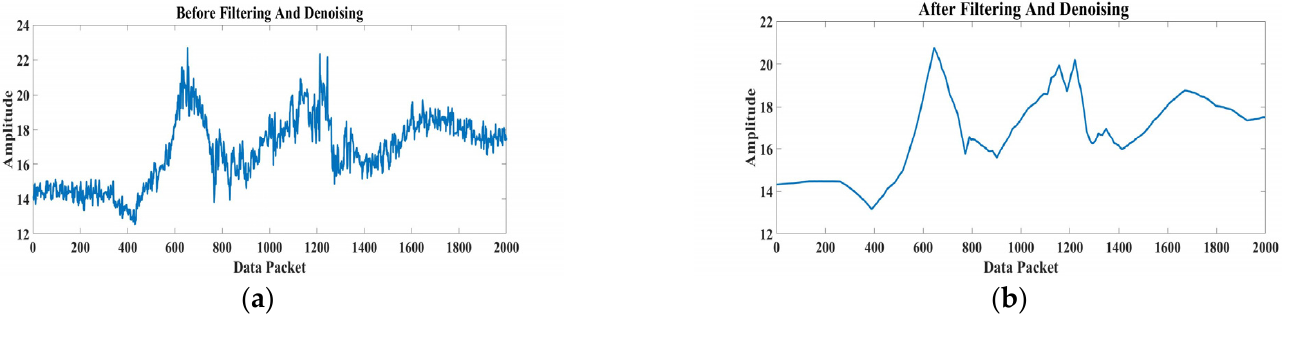
Figure 6. The above figure shows the before and after comparison of wavelet processing algorithm: ( a ) Before filtering and denoising; ( b ) After filtering and denoising. ( a ) Before filtering and denoising; ( b ) After filtering and